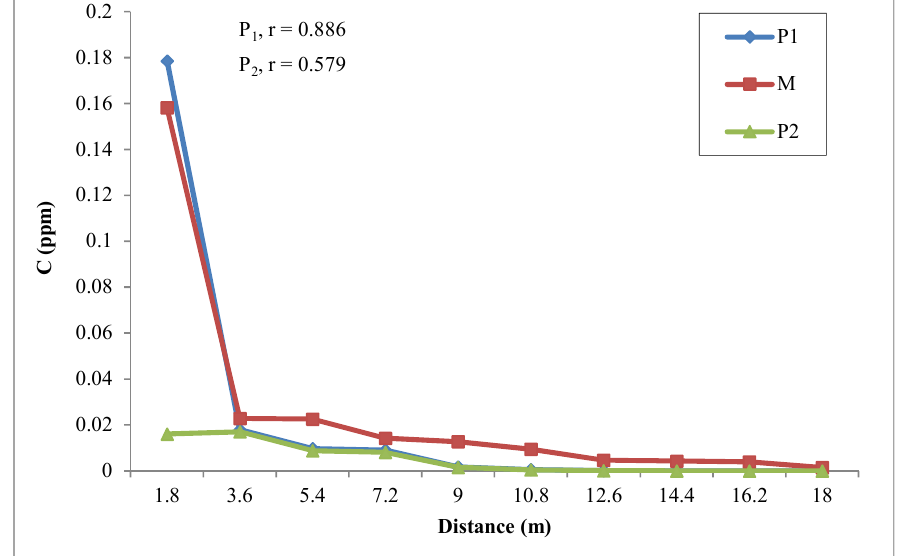
Figure 11. Measured and Predicted Concentrations against Distance for the month of March.